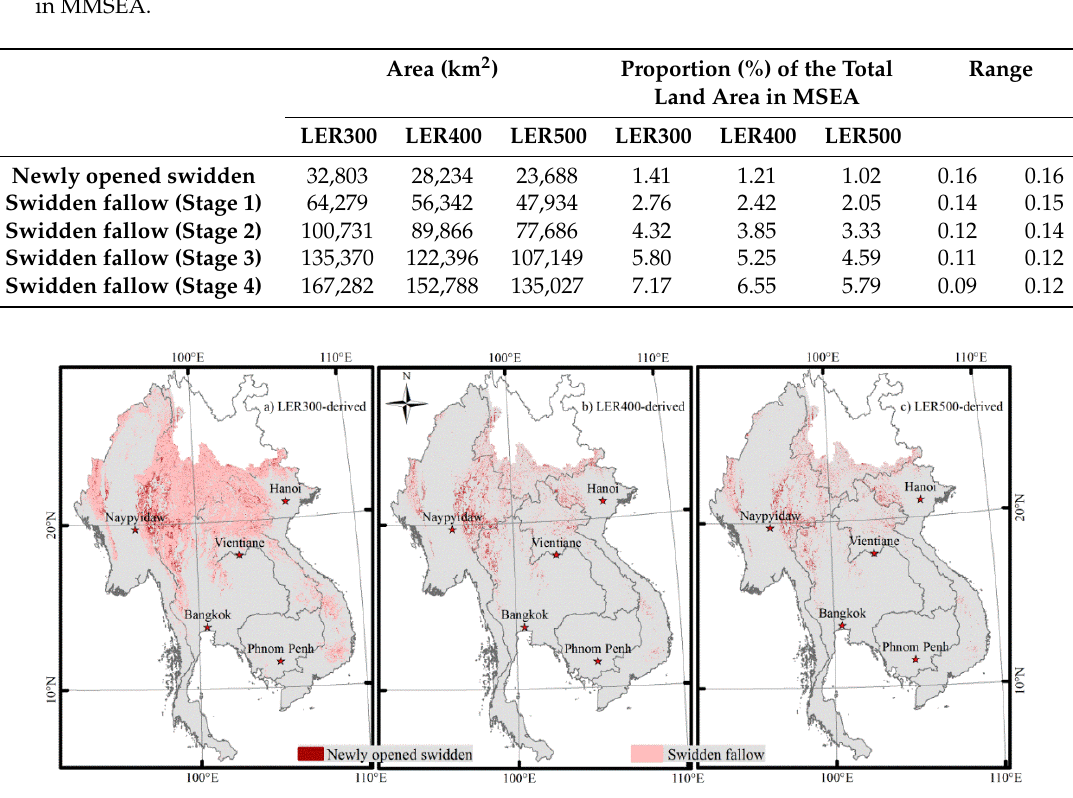
Figure 6. LER300-, LER400- and LER500-derived maps of swidden agriculture landscape in MMSEA.